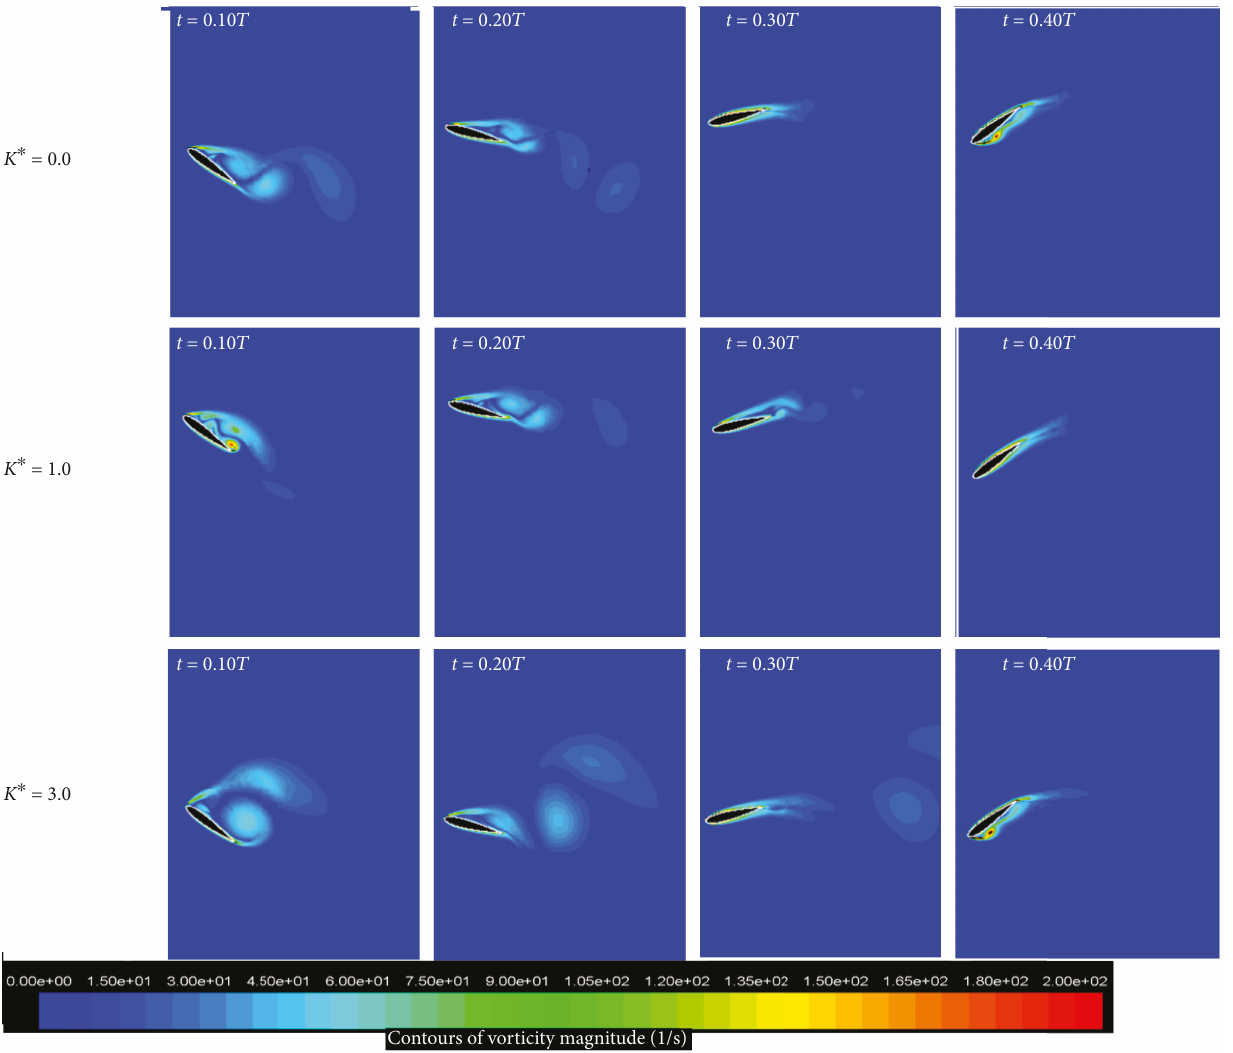
Figure 9: The vorticity contours of the considered cases with K ∗ = 0 0 , 1.0, and 3.0, C ∗ = 1 0